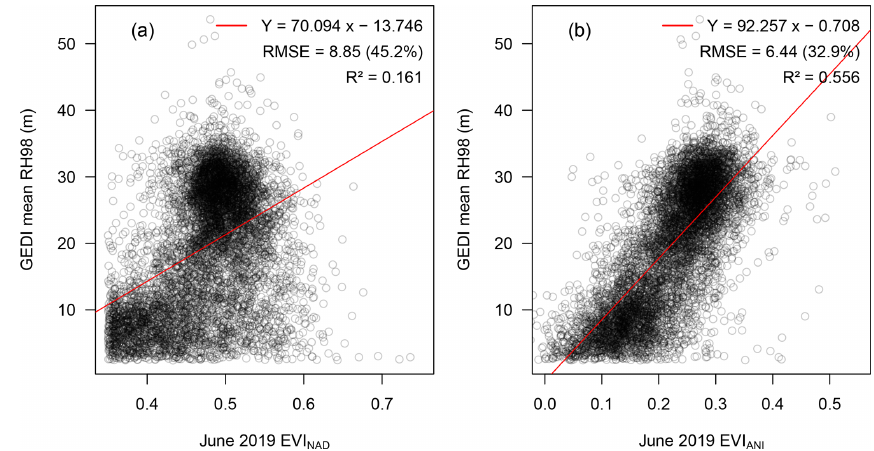
Figure 5. Relationship between forest height (GEDI mean RH98) and two AnisoVeg layers obtained in June 2019 over the Amazon. (a) EVI NAD and (b) EVI ANI . The RH98 metric is the relative height at the 98th percentile, which represents the top of canopy height. A total of 7000 random matching pixels were used in this analysis (1% of 700000 total matching pixels available), resulting from the filtering of both GEDI and AnisoVeg data. The red line indicates the fitted line by a simple linear model.